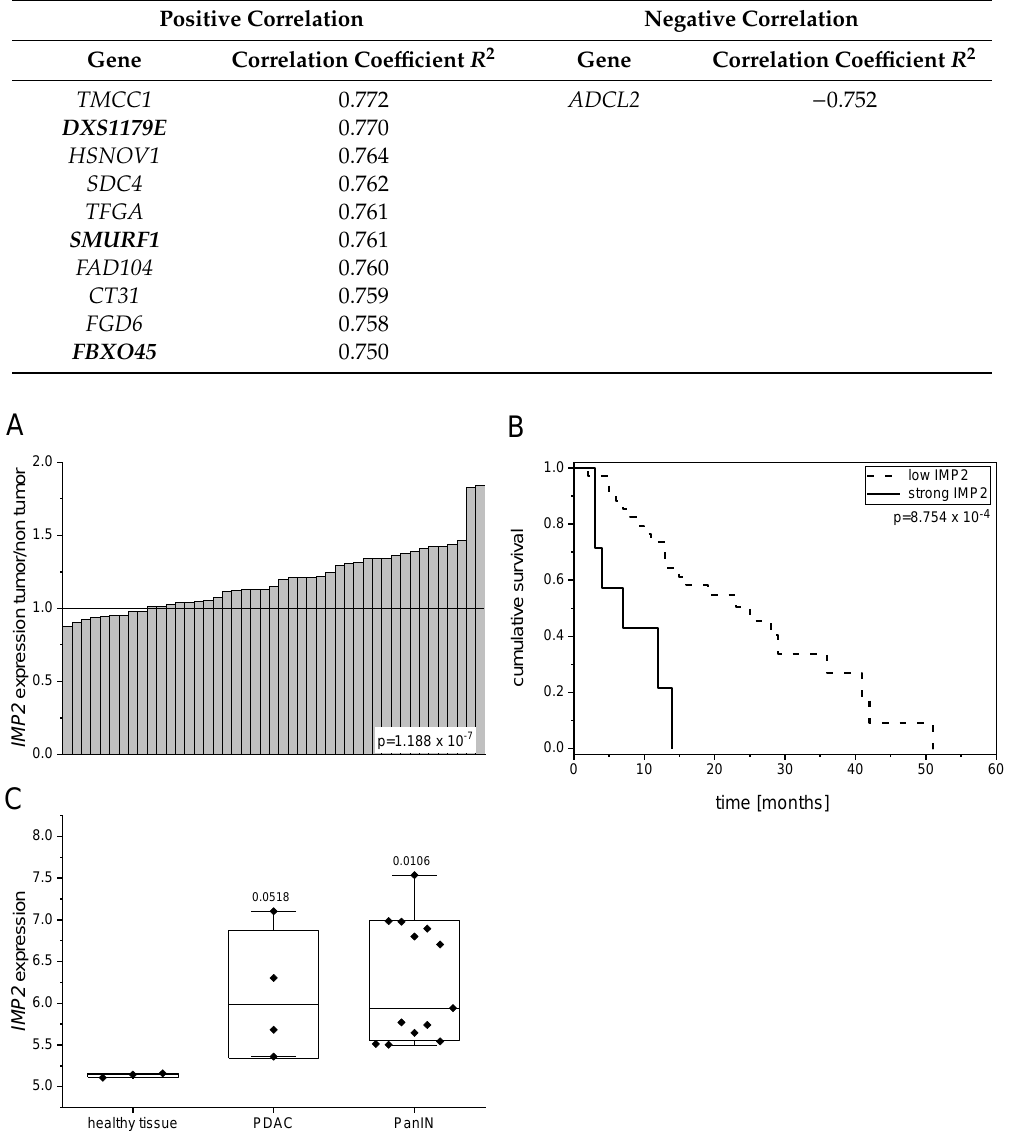
Figure 1. IMP2 is overexpressed in PanINs and PDAC and leads to lower rate of survival. ( A ) Expression levels of IMP2 in human PDAC cohort as compared with matched normal pancreatic tissue (GEO ID: GSE28735; p = 1.188 × 10 − 7 ; n = 45); ( B ) Kaplan-Meier estimated cumulative survival of PDAC patients with strong or low IMP2 expression (GEO ID: GSE28735; p = 8.754 × 10 − 4 ; low IMP2 expression in tumor tissue < 6, n = 35; strong IMP2 expression > 6, n = 7); ( C ) IMP2 expression levels ± SEM in human PDAC and PanIN lesions (GEO ID: